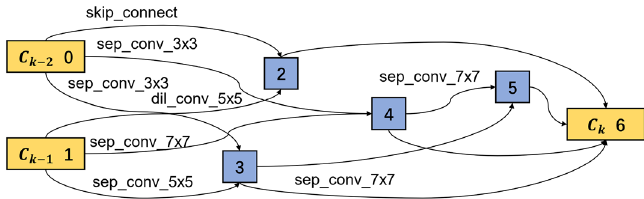
Figure 17. Optimal reduction cell structure for RUL